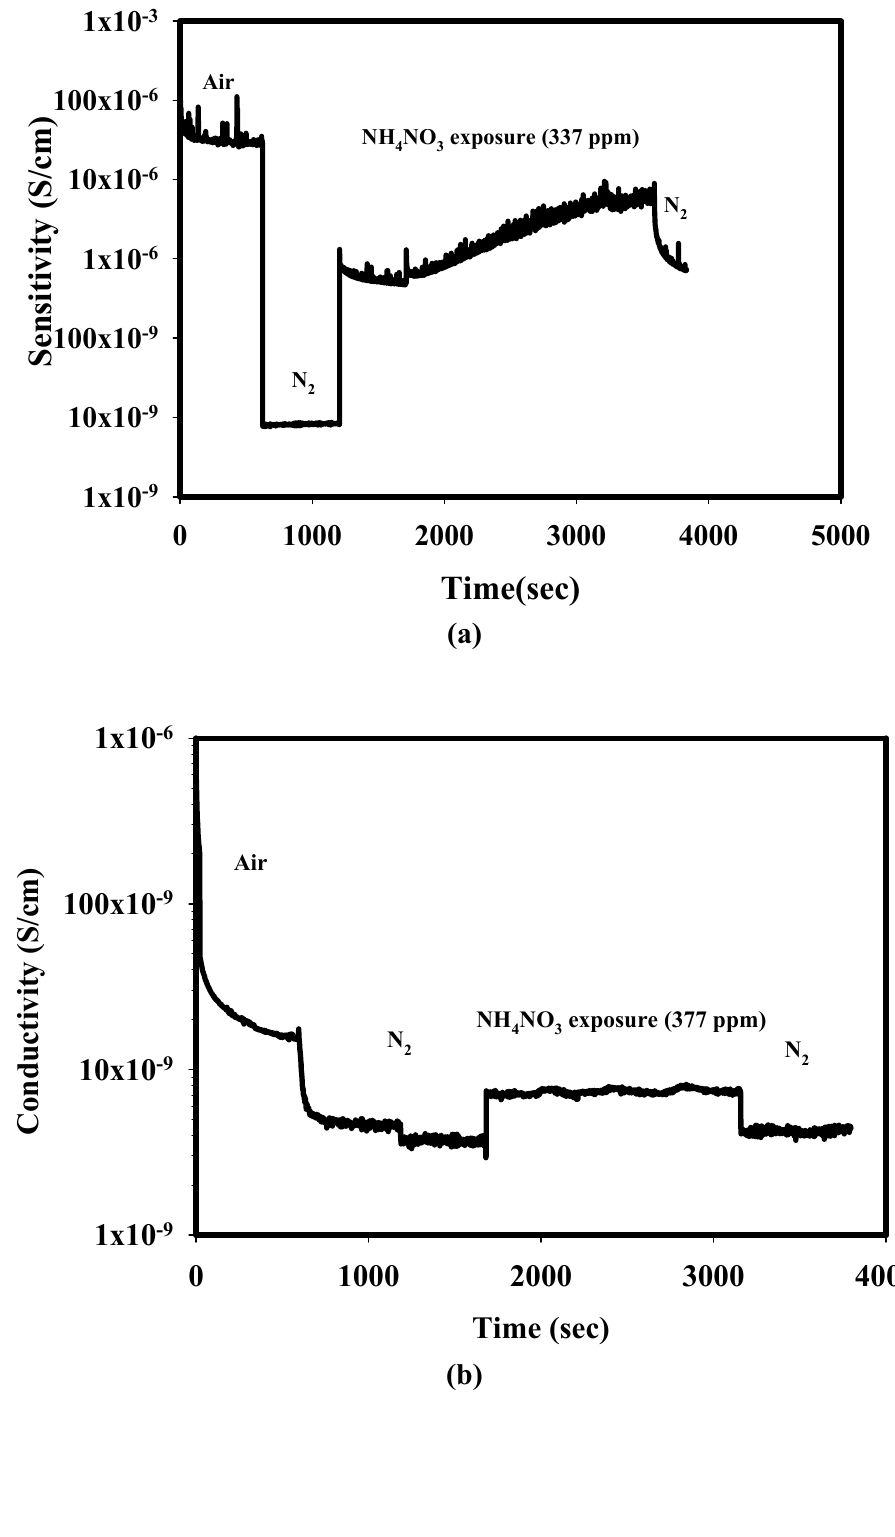
Figure 2. The responses of: (a) doped PPV; (b) Zeolite Y (H + , Si/Al = 5.1); and (c) dPPV/Zeolite Y (H + , Si/Al =